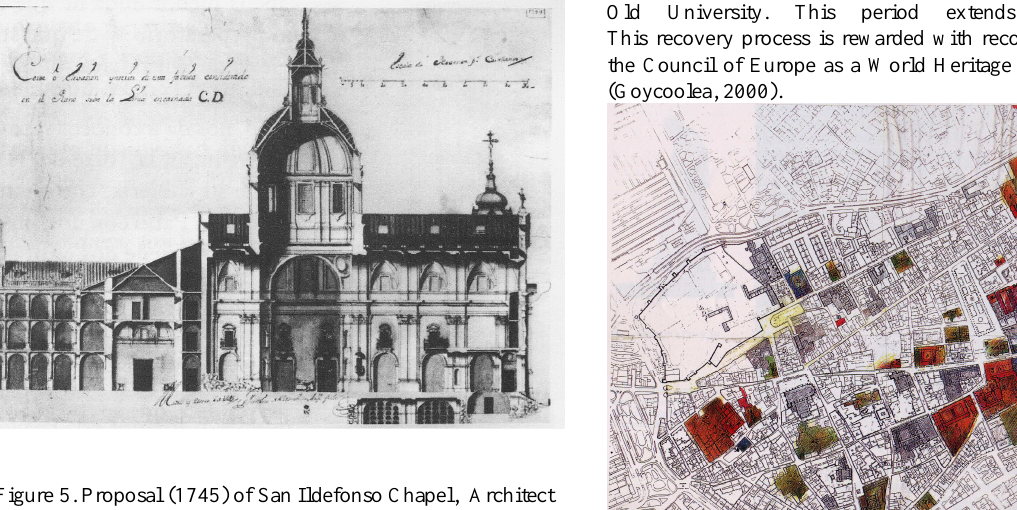
Figure 5. Proposal (1745) of San Ildefonso Chapel, Architect Francisco de Moradillo (biblioteca Nacional, Barcia nº 1399).